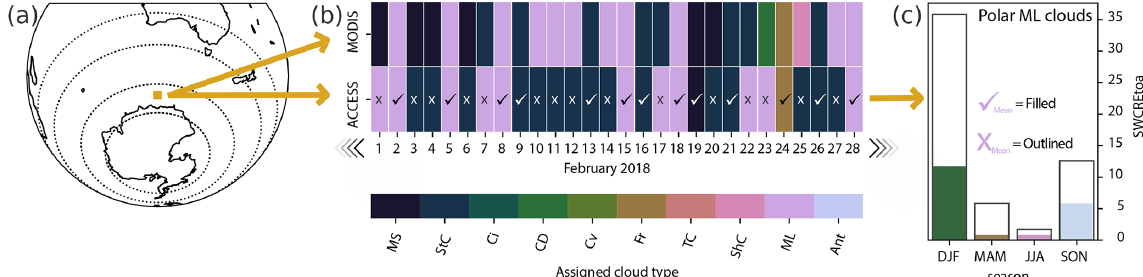
Figure 6. For each grid box (a) and for every point in time (b) , the cloud type has been determined via k -means clustering for the MODIS product and subsequently fitted to the ACCESS-AM2 output. The assignment of cloud type is shown for a 1-month period in (b) , where we can see where ACCESS-AM2 correctly (shown by a tick) or incorrectly (shown by a cross) simulates the same cloud type as the MODIS product. Using this information, we calculate the seasonal mean radiation or cloud property bias (c) over the instances where ACCESS correctly (filled bars) or incorrectly (outlined bars) simulated the cloud type for the three regions of the Southern Ocean. As an example, (c) shows the mean radiation biases for polar mid-level